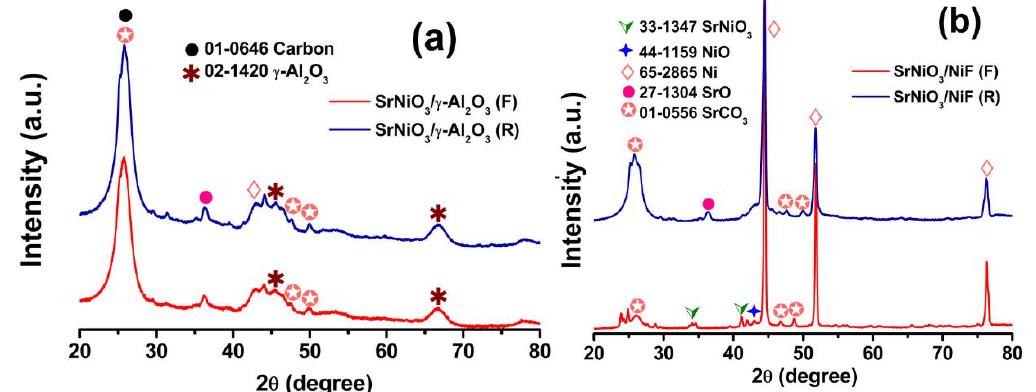
Figure 14. X-ray diffractogram of used catalyst ( a ) SrNiO 3 / γ- Al 2 O 3 (F and R) and ( b ) SrNiO 3 /NiF (F and R) after DRP for 50 h.